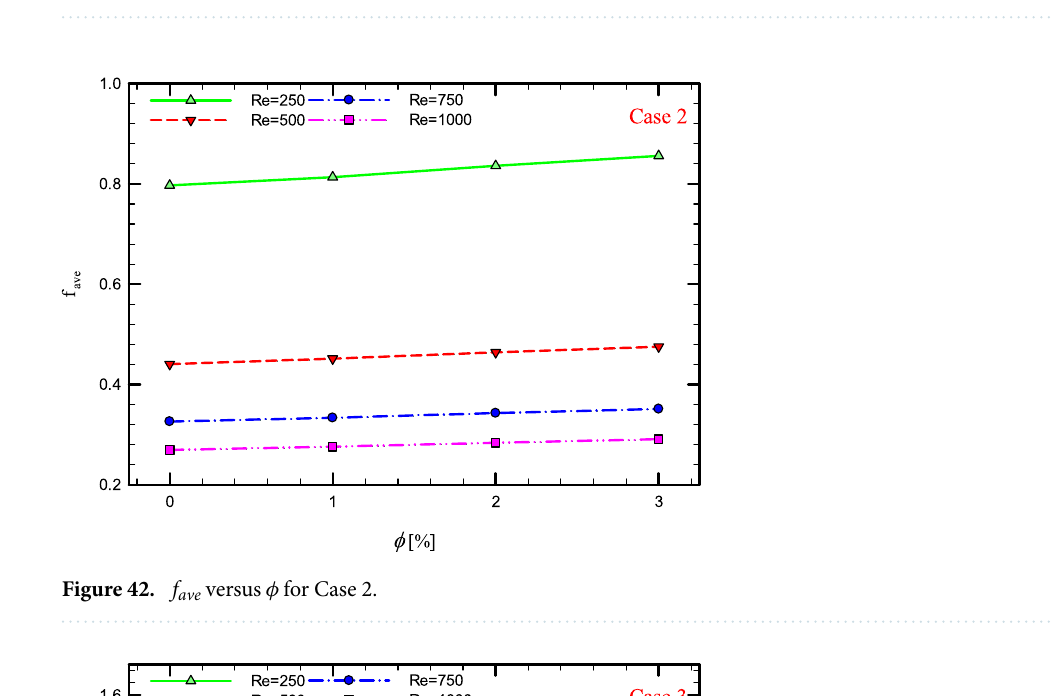
Figure 41. f ave versus φ for Case 1.